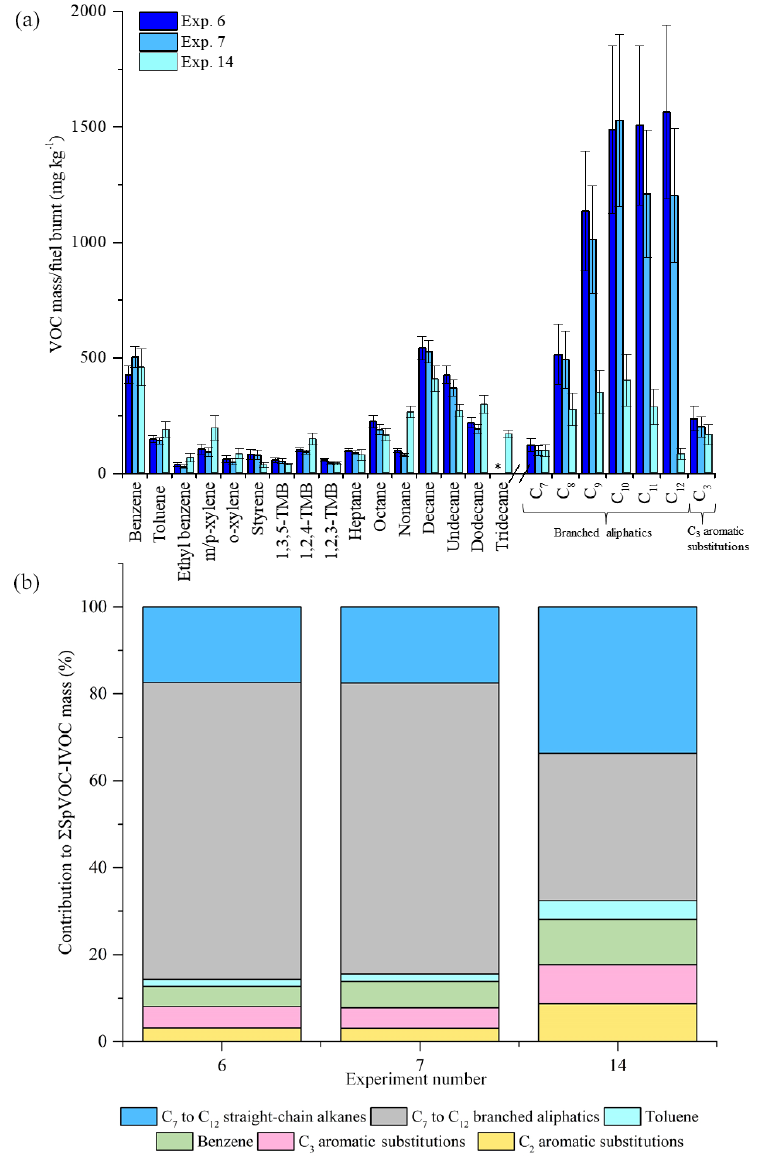
Figure 7. Comparison of measured VOC-IVOC emissions rates in replicate cold-start experiments 6 and 7 (fuel batch A) with cold-start experiment 14 (fuel batch B) (a) . Comparison of the percentage contribution of the individual and grouped compounds to the P SpVOC- IVOC emission rates in experiments 6, 7, and 14 (b) . The emission rates of tridecane and the C 13 branched aliphatic grouping has not been included in (b) to allow direct comparison between other experiments where these species were not measured. Error bars represent the calculated uncertainty in the measured emission rates, see Sect. S1.1 for further